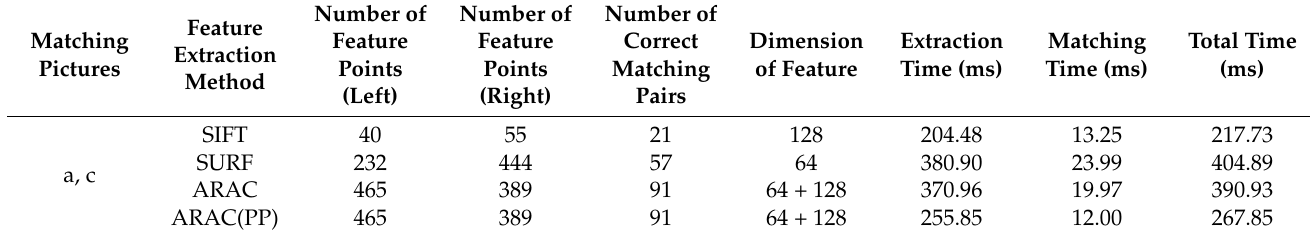
Table 3. Matching results under the condition of illumination change and large-angle affine transformation. Matching Pictures